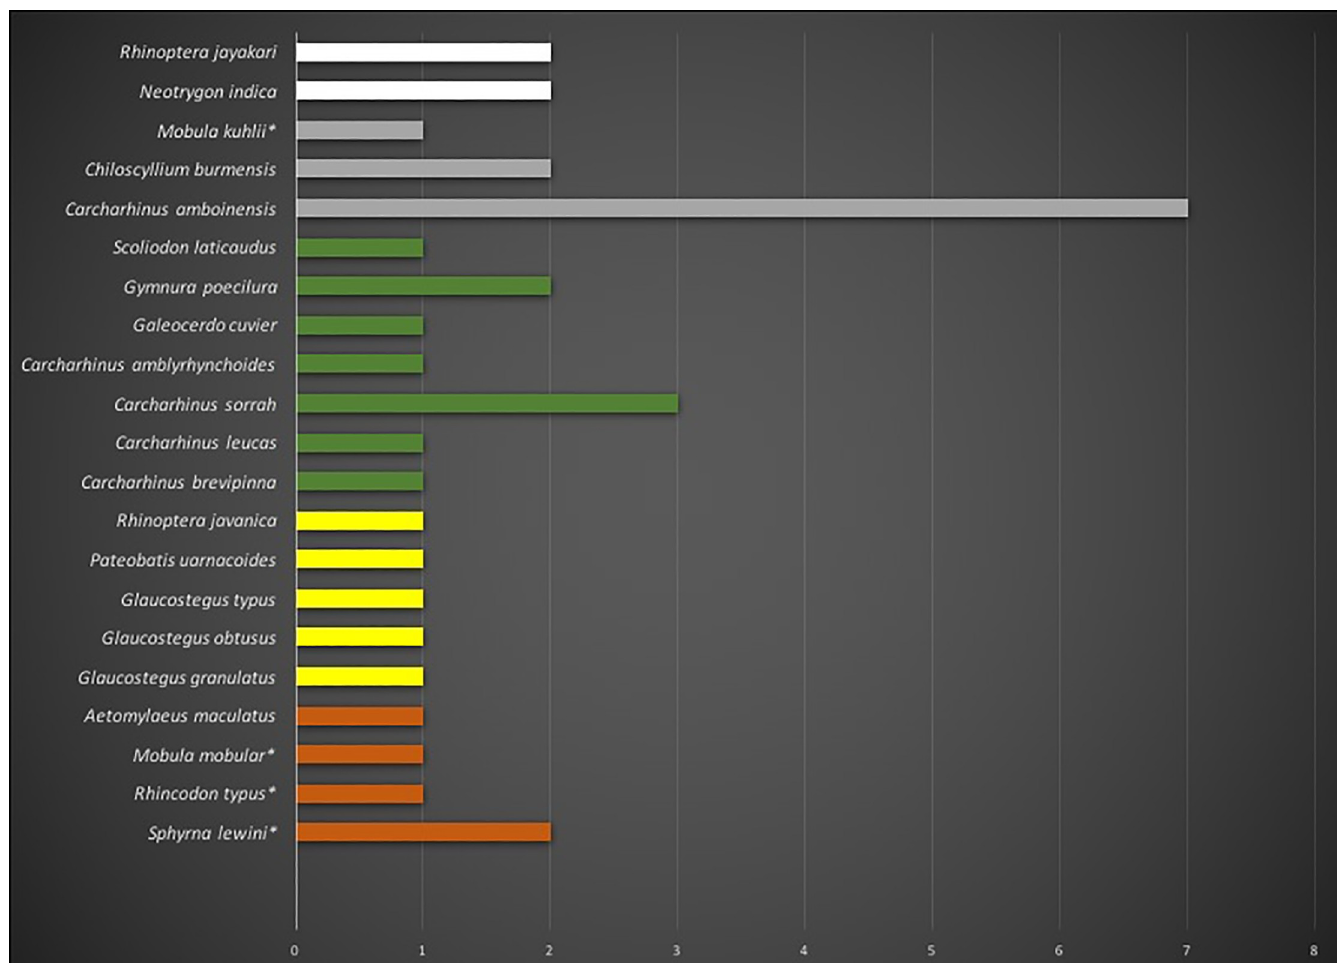
Fig 3. Species identifications for 34 elasmobranch products (dried, semi-dried, or salted meat and fins). Bar length represents abundance; color and order (Y-axis) correspond to IUCN Red List of Threatened Species status (Orange: EN, yellow: VU, green: NT, gray: DD and white: not assessed). Species currently listed in CITES Appendix II in 2017 are marked with